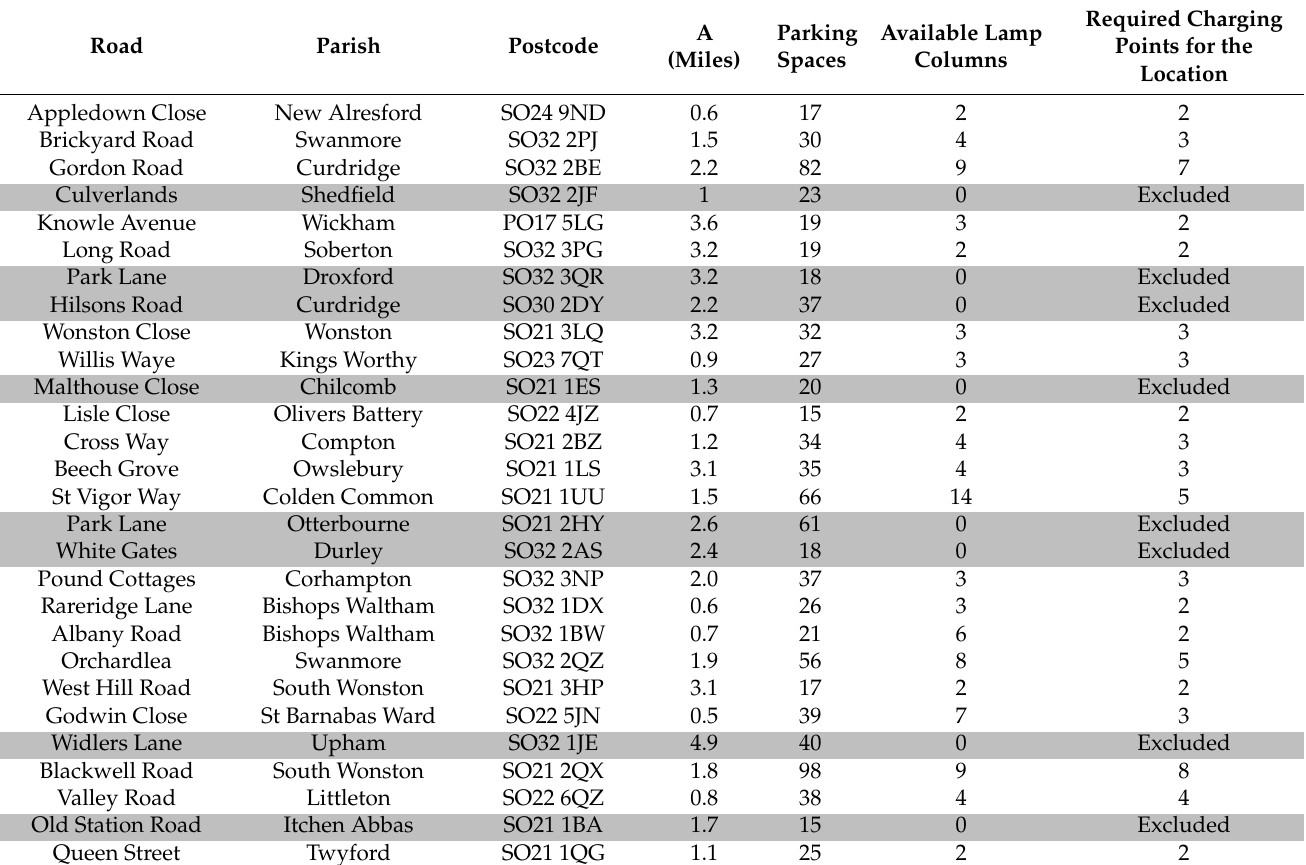
Table 5. Selected optimal EV on-road charging point locations for Winchester District and distance from nearest car park (A). The color intended to highlight the excluded streets due to lack of suitable grid